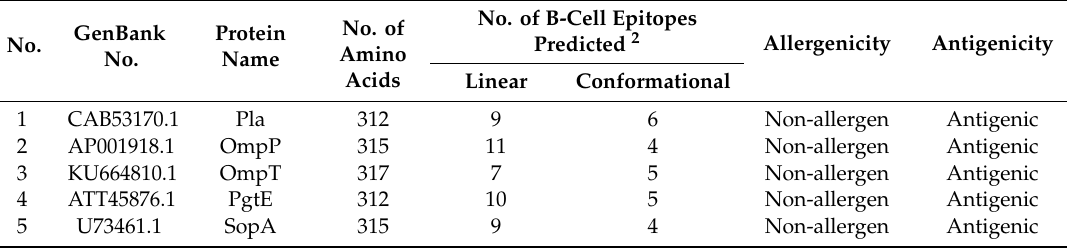
Table 1. Antigenic and allergenic results of the predicted omptins 1